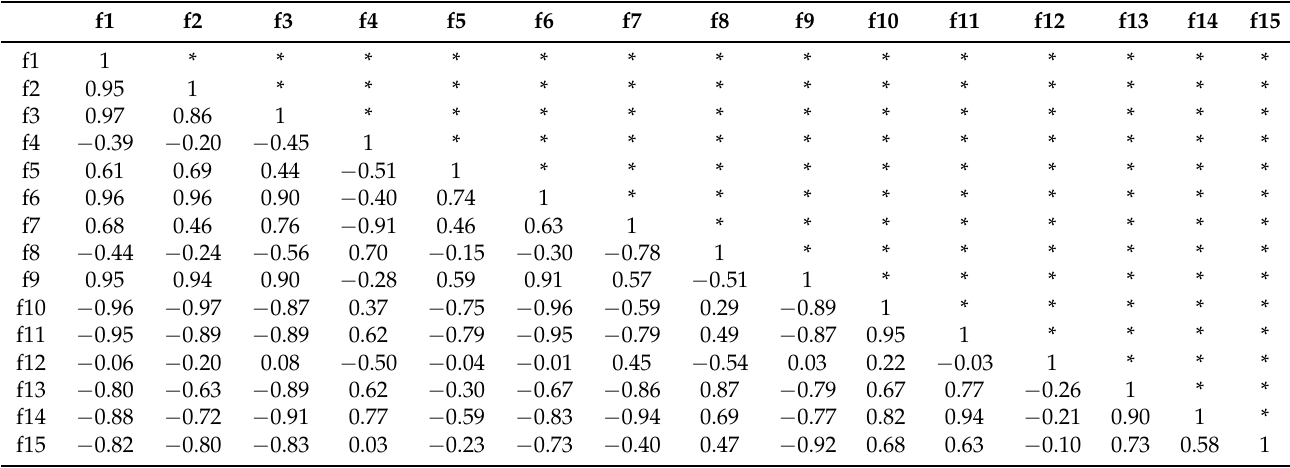
Table 6. Pearson correlation coefficients for each pair of features. The fi ( i = 1,...,15 ) represents f 0, SPL, duty ratio, CPP_MIC, jitter_MIC, shimmer_MIC,